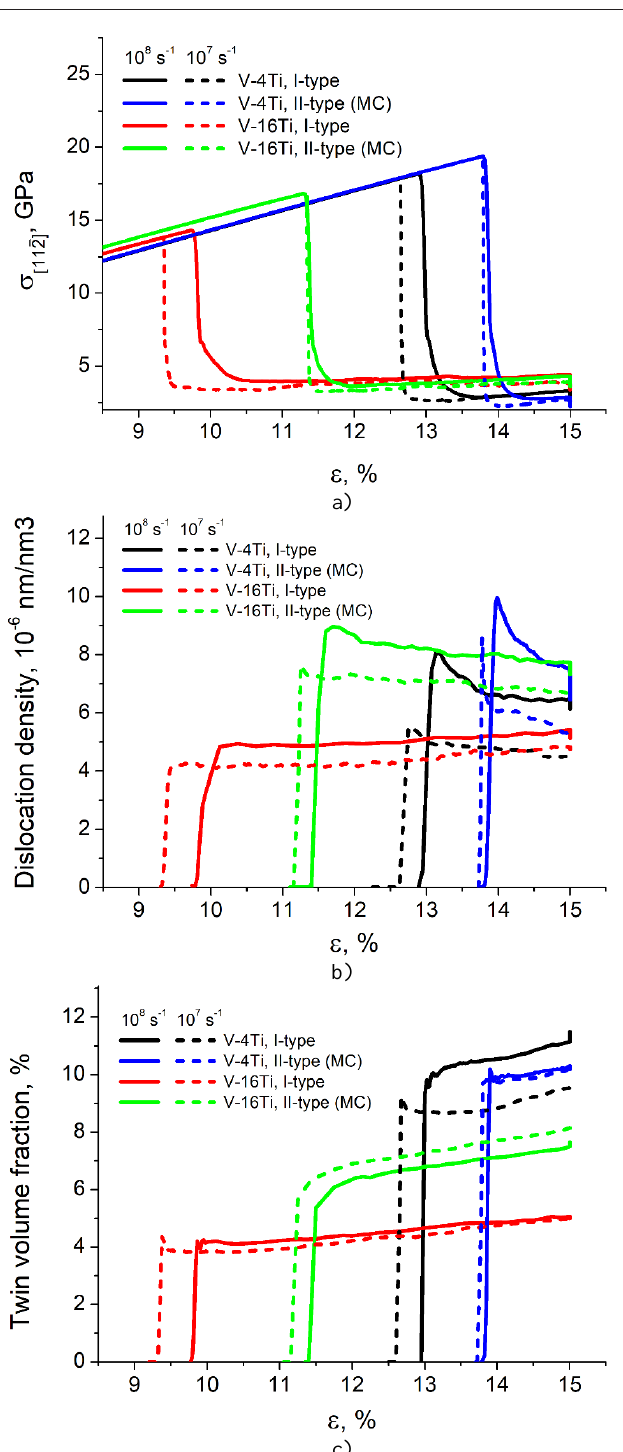
Fig. 2. Dependence of the tensile stress (a), dislocation density (b), the volume fraction of twins (c) on the magnitude of the tensile strain for crystallites of various stoichiometric compositions